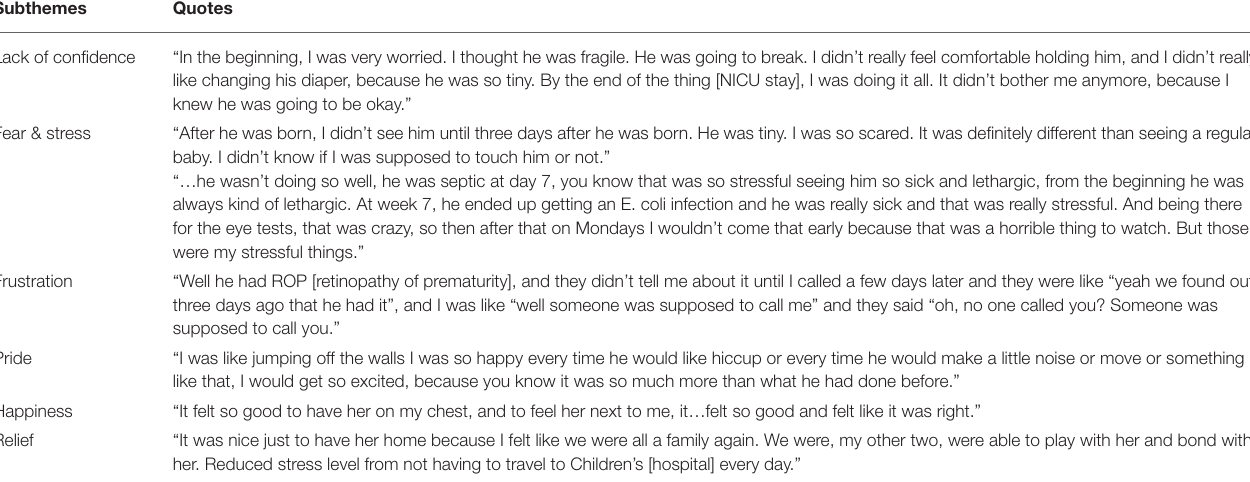
TABLE 7 | Theme 5: Emotions from mothers.